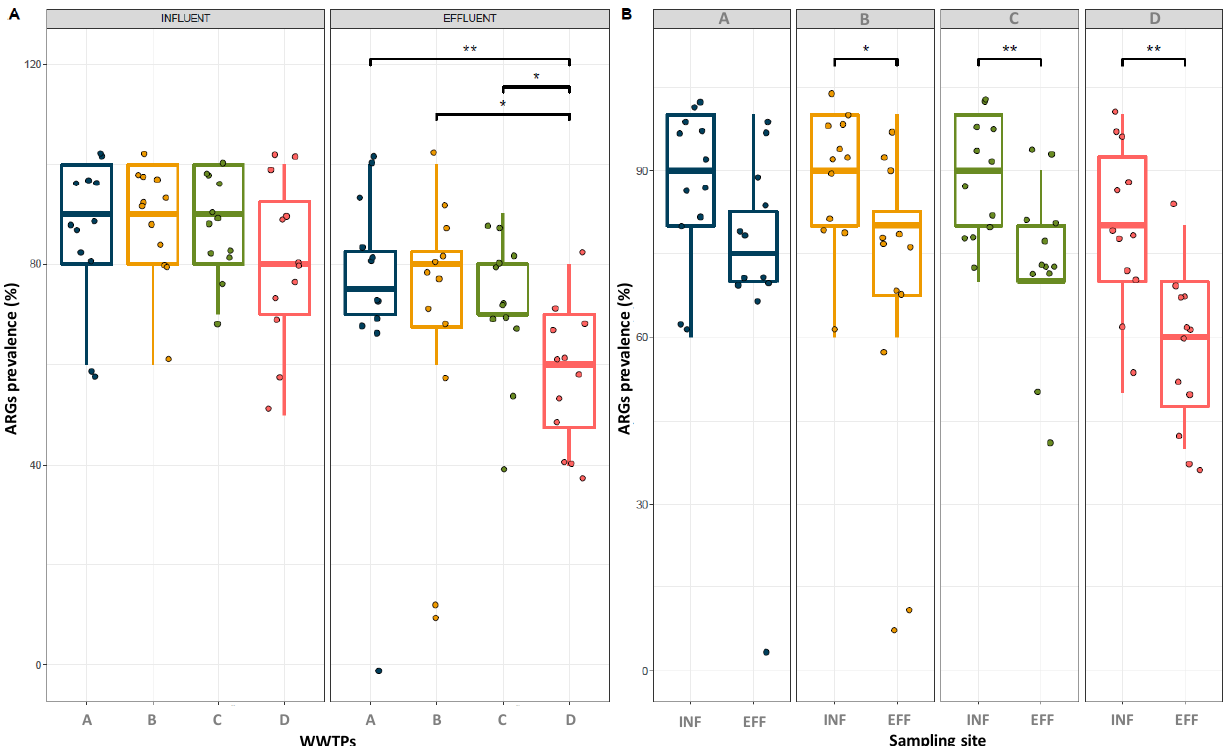
Figure 3. Boxplot of the prevalences (%) of ARGs detected in influent and effluent samples of each Urban Wastewater Treatment Plant (WWTP). ( A ) shows significant differences between WWTPs, and ( B ) shows significant differences between influent and effluent samples for each WWTP. Solid horizontal lines represent the median, and the boxes display the 25 – 75% quartile range. Only significant p values ( p < 0.05) obtained from the Wilcoxon signed-rank test analysis are indicated (*, **). A high abundance of ARGs in influent and effluent waters was previously reported after the extensive surveillance of 12 urban WWTPs located in seven countries (Portugal,